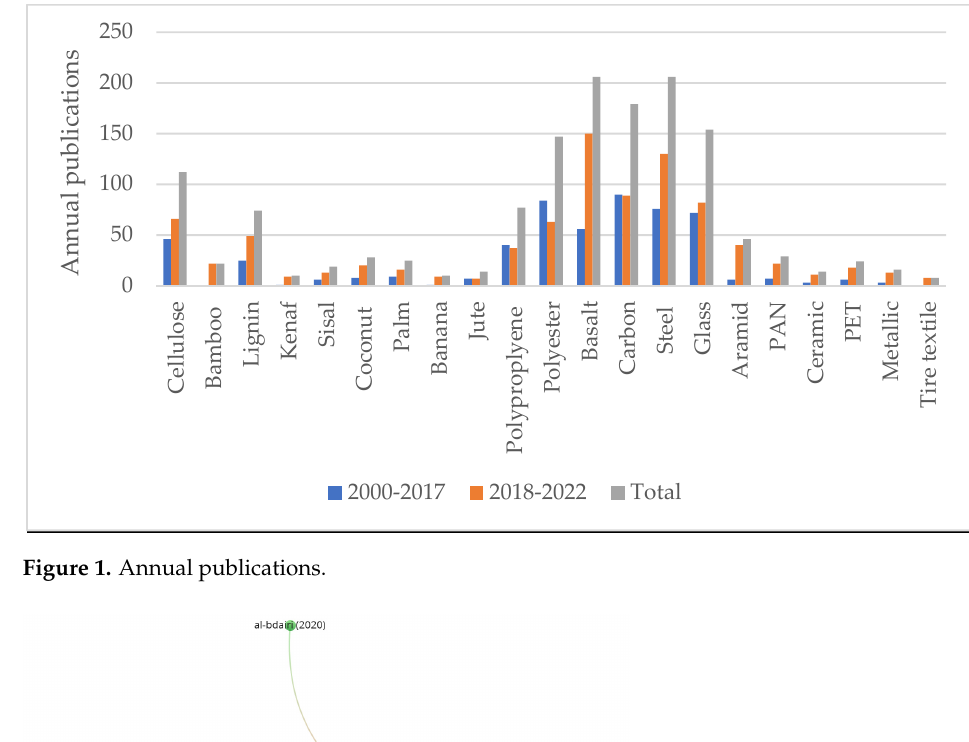
Figure 1. Annual publications .